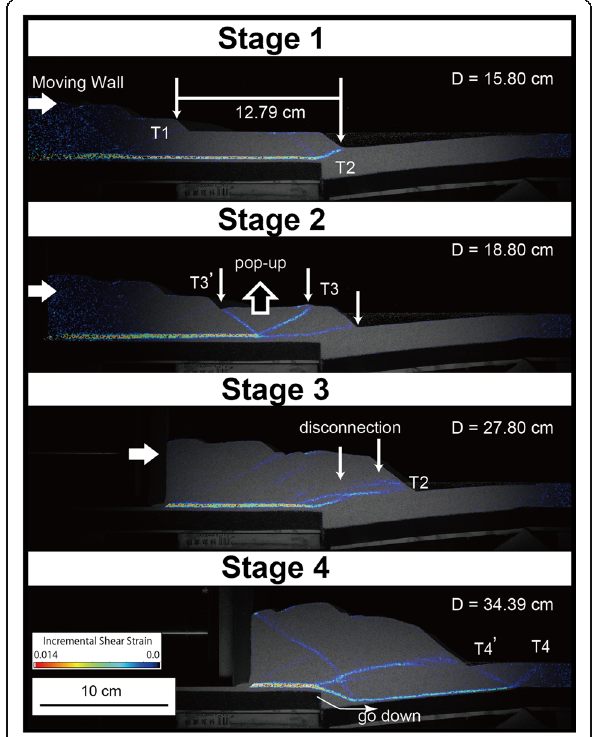
Fig. 4 Deformation timeline with convergence of half-graben basement without trench-fill (EXP 2). The shortening (D) increases from the top to the bottom. The incremental shear strain becomes larger in the order from blue to red in the color reference. Incremental shear strain indicates relative, not absolute, quantity Fig. 5 Schematics of dancing. a